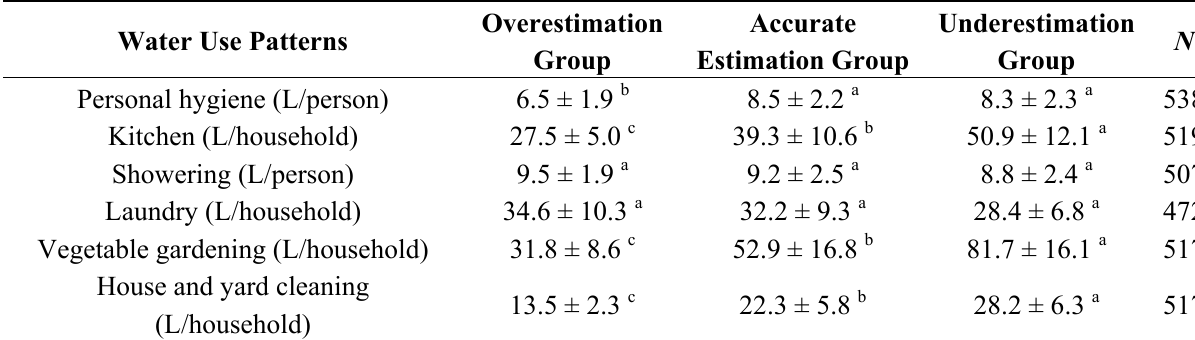
Table 4. Water use patterns under different estimation groups.